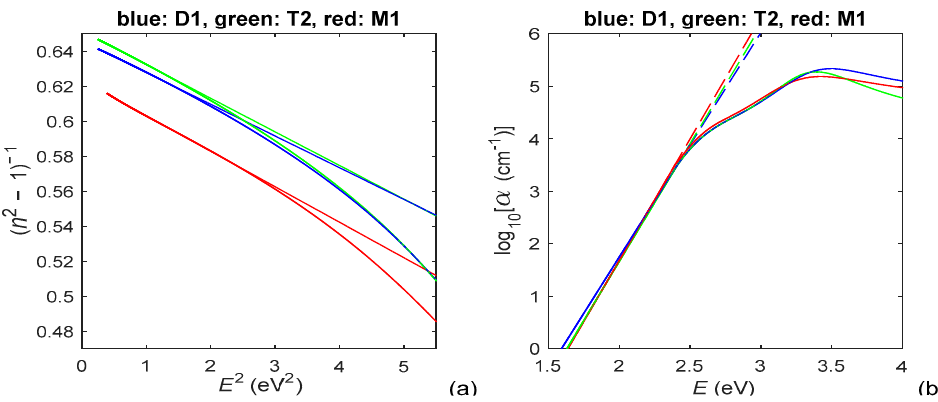
( b ) Urbach plot, utilizing k ( E ) from Figure 2b, for the same films.